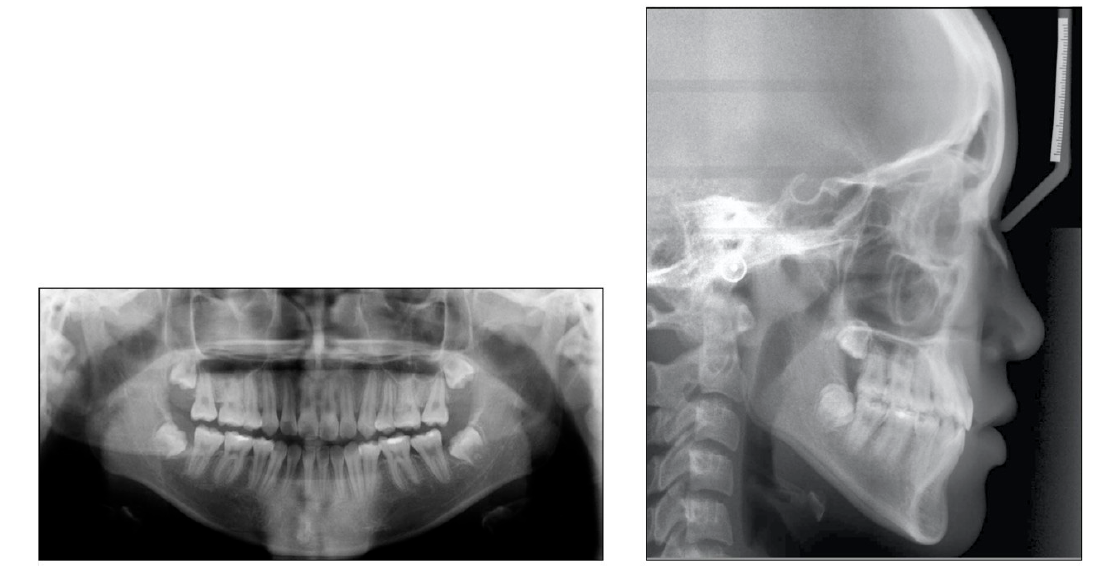
Figure 6. Case 1, Posttreatment panoramic radiograph and lateral cephalogram.